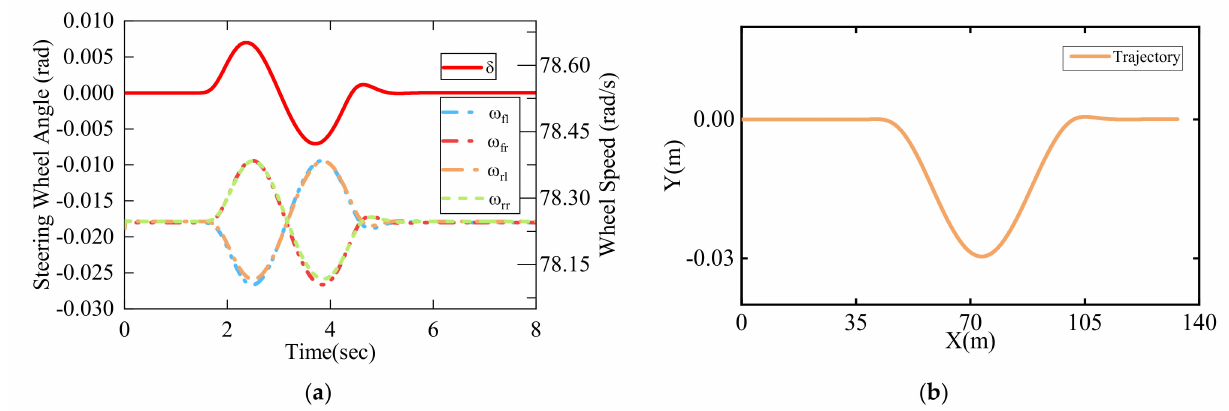
Figure 6. Sinusoidal steering condition: ( a ) observer input, including front wheel angle and four-wheel speed; ( b ) vehicle trajectory.